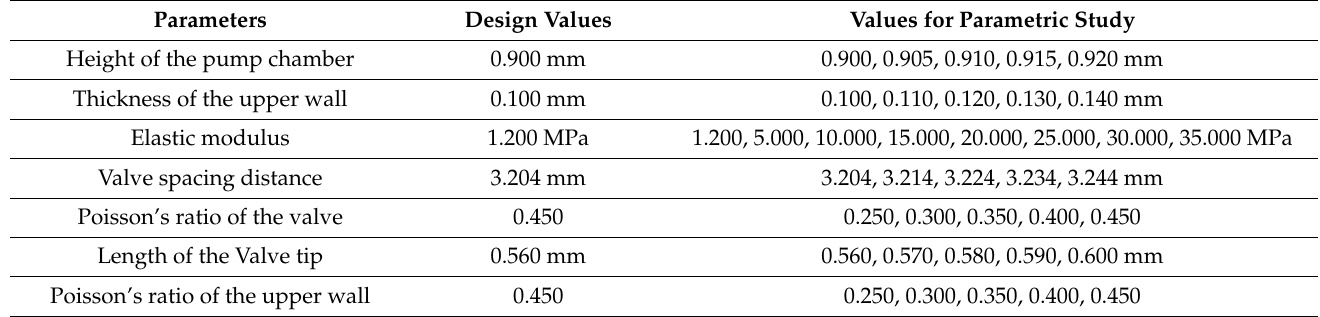
Table 5. Percent error of the flow rates between this study and parametric study